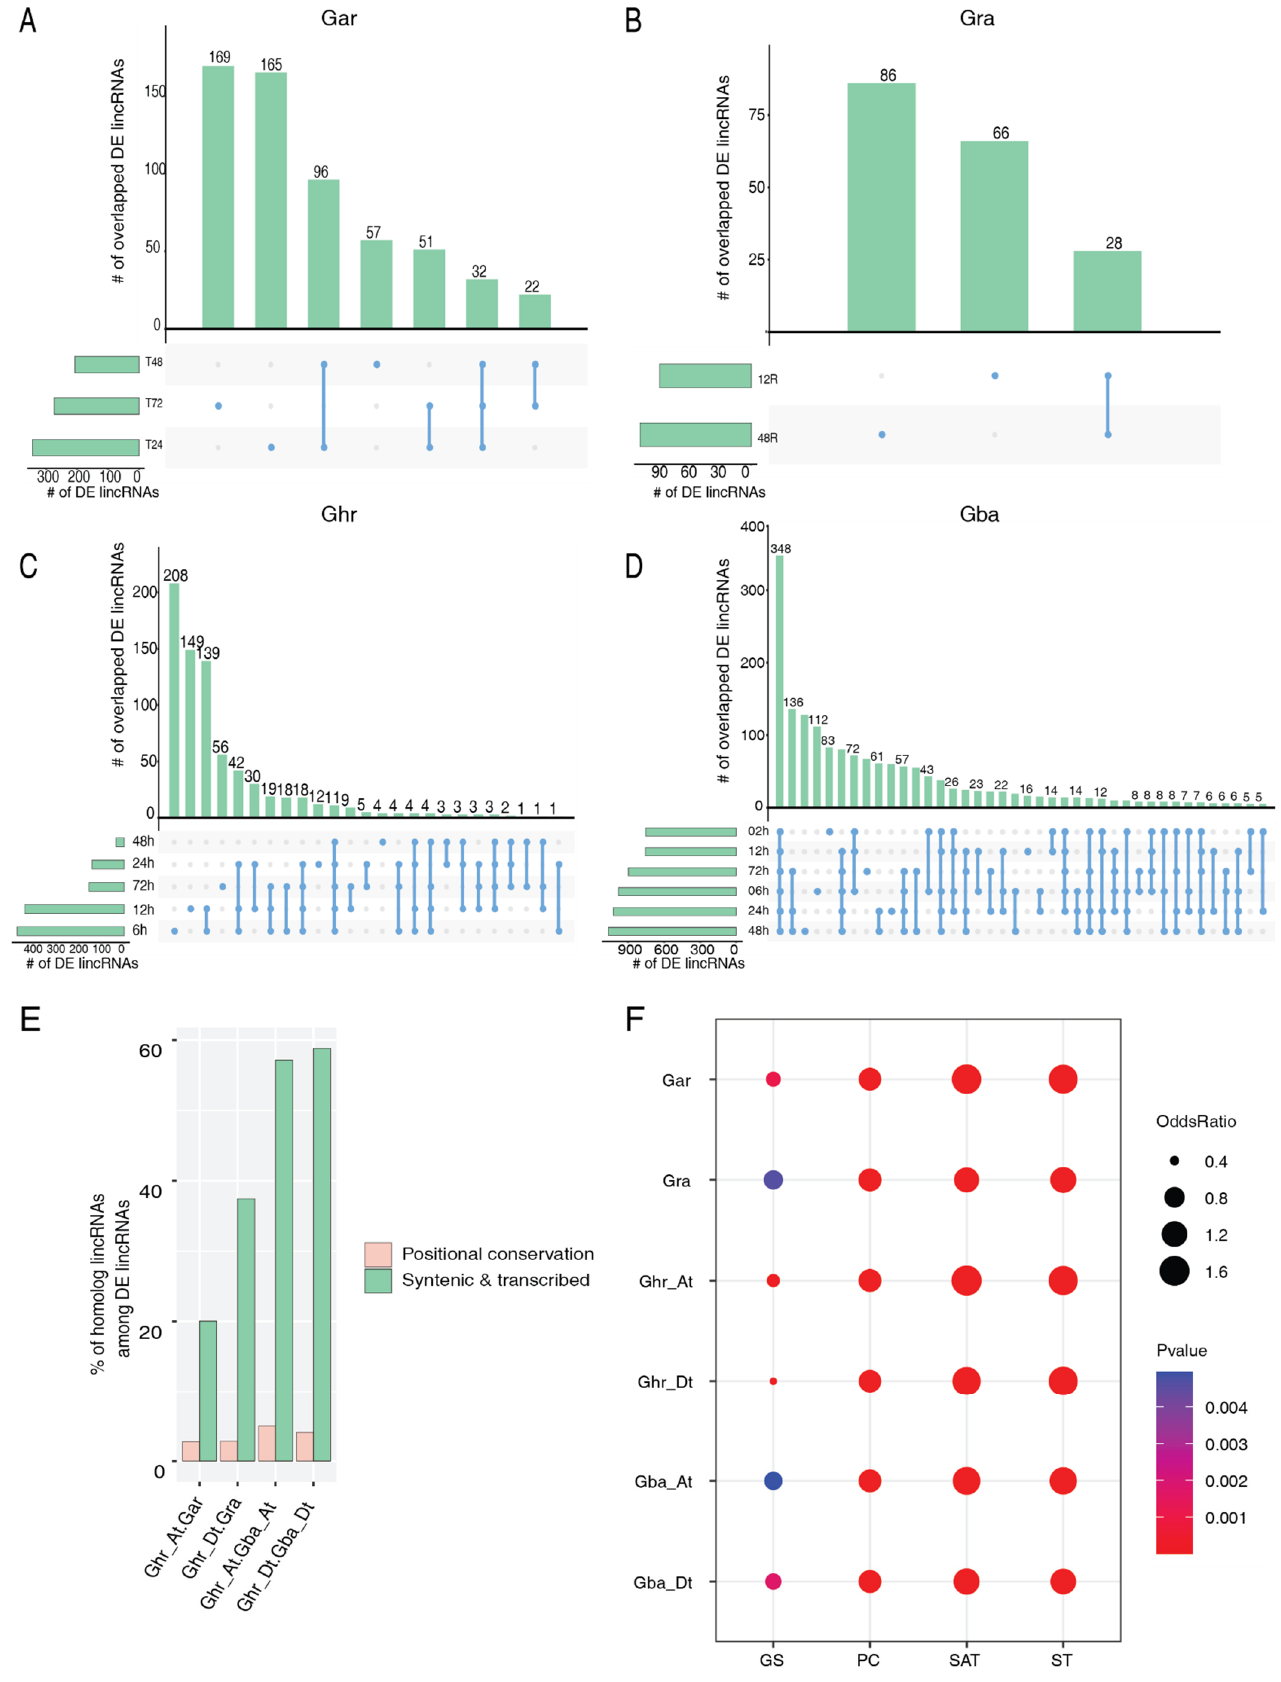
Figure 3. LincRNAs responding to Vd infection and their conservation. ( A ) The number of differen- tially expressed Vd -responsive lincRNAs at different time points in G. arboreum (Gar). Horizontal